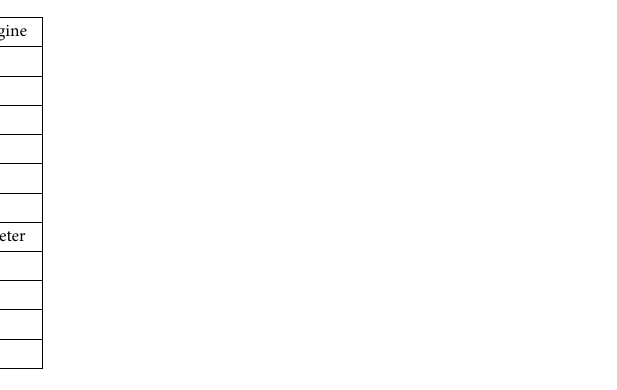
Table 2. Test rig specification.